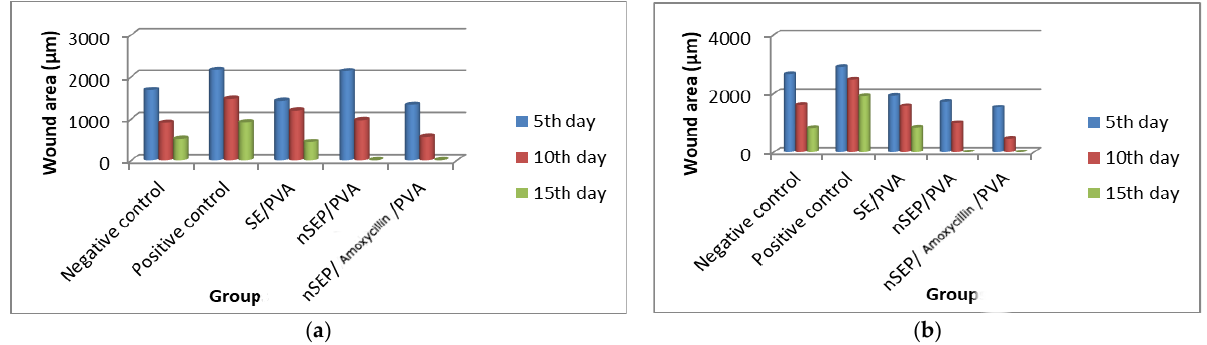
Figure 8. Wound contraction area ( a ): nondiabetic and ( b ): diabetic.